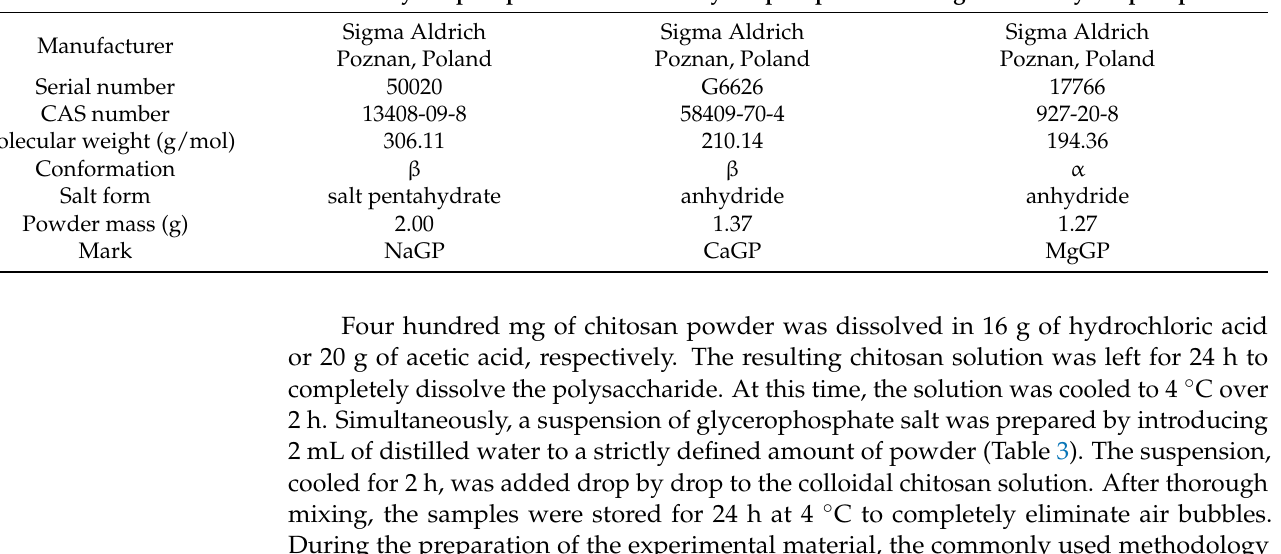
Table 3. Summary of glycerophosphate salts used in research. Disodium Glycerophosphate Calcium Glycerophosphate Magnesium